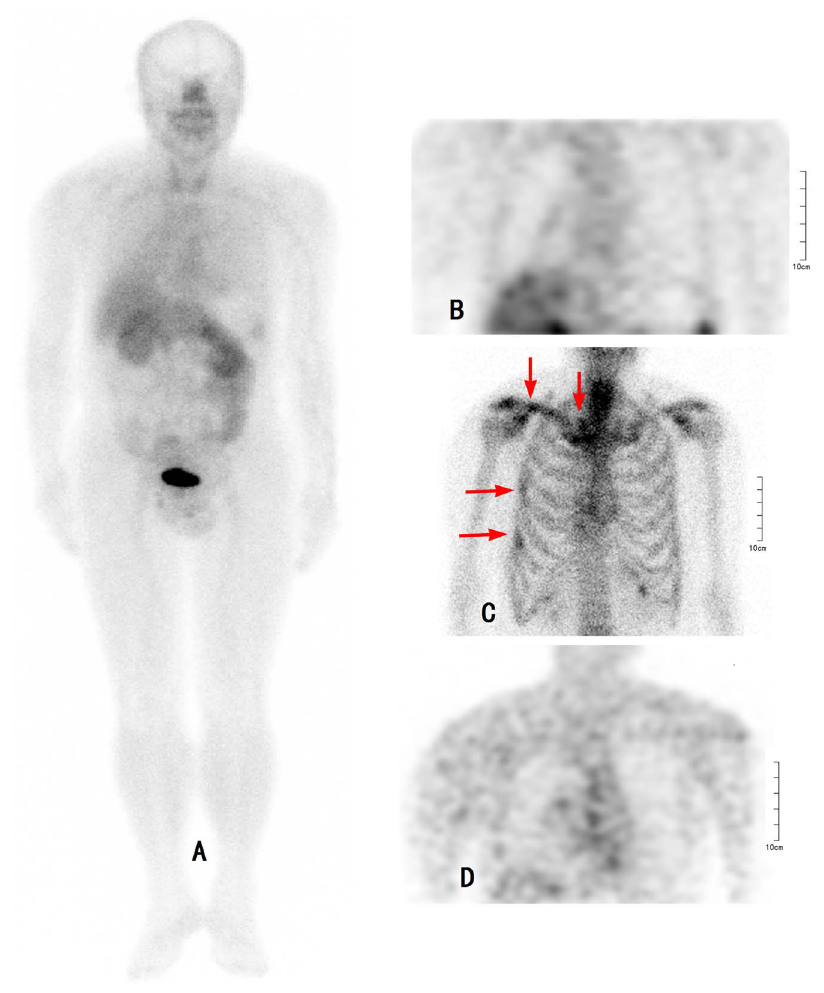
Figure 2. Comparison of 99m Tc-3PRGD2 SPECT, 99m Tc -MDP bone scan, and 18 F-FDG PET in a 60 year-old patient with a recent fall- down trauma. The 99m Tc -MDP bone scan was positive (red arrows), whereas both 99m Tc-3PRGD2 SPECT and 18 F-FDG PET were negative. A: 99m Tc- 3PRGD2 WB (-), B: 99m Tc-3PRGD2 SPECT ( 2 ), C: 99m Tc-MDP bone scan ( + ), D: 18 F-FDG PET ( 2 ). WB: whole body.